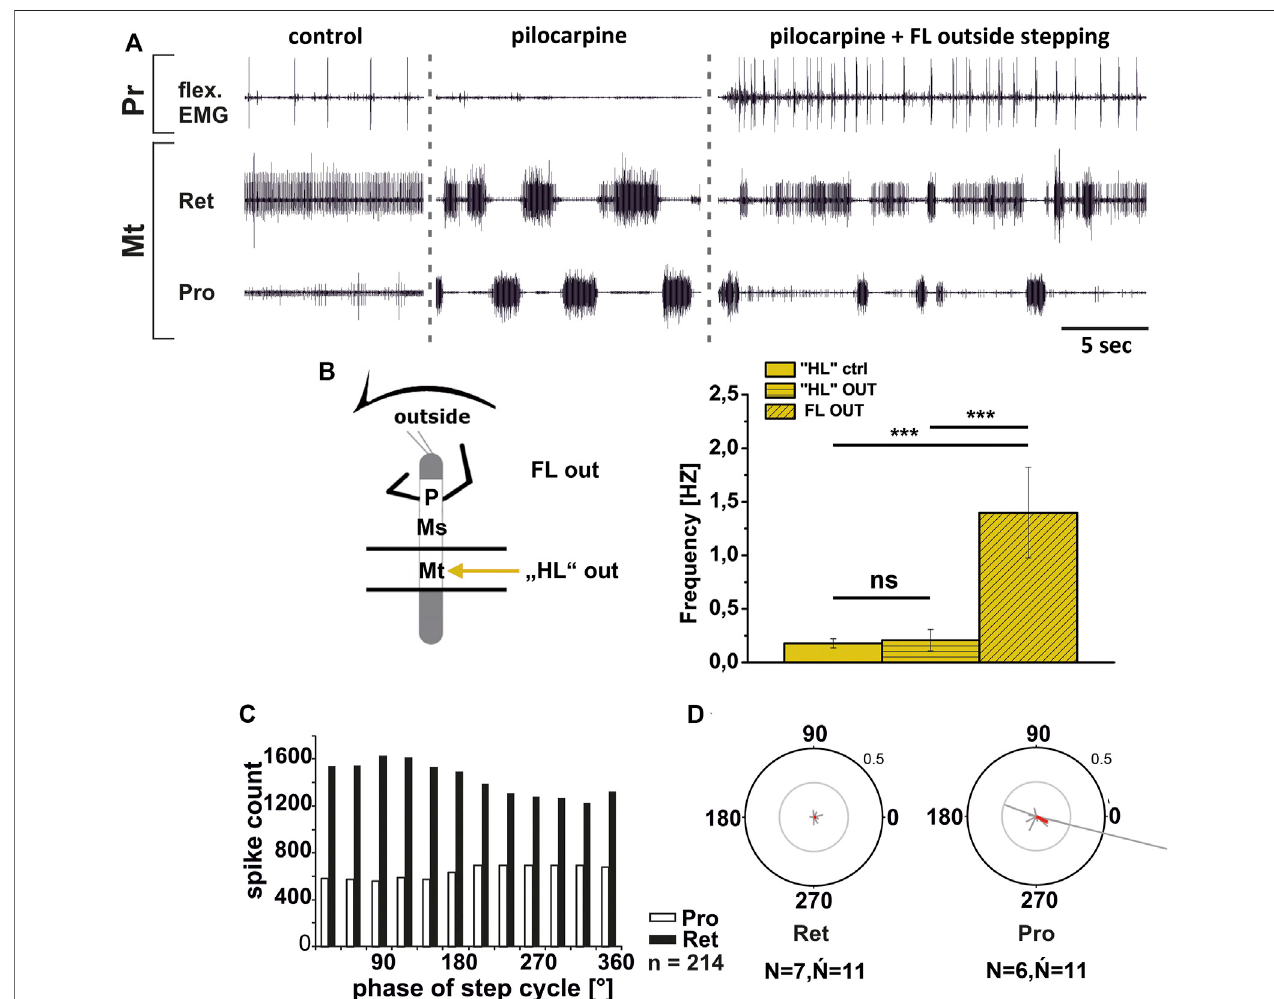
FIGURE7| Motoroutputof protractor (Pro)and retractor (Ret) coxae MNpoolsinthepilocarpineactivateddeafferentedmetathoracicganglionduringfrontleg(FL) outside stepping; (A) . FL Flexor EMG ( “ fl ex ” , top), and extracellular recordings of the ipsilateral metathoracic retractor (second trace) and protractor (third trace) nerve during control outside steps, in pilocarpine w/o FL steps, and during outside stepping under pilocarpine application; (B) . Schematic of experimental split-bath con fi gurationwithcomparison ofnl2pilocarpinecontrolBurstfrequency( “ HL ” ctrl)withdeafferentHL-segmentnl2burstfrequency( “ HL ” OUT)duringoutsidesteps of the front legs (FL OUT) from 14 walking sequences in 10 experiments (signi fi cance level < 0.001); (C) . Phase histogram of retractor and protractor nerve activity under pilocarpine during outside stepping, with respect to the FL step cycle; (D) . Polar plots with the spike event maxima (grey vectors) and their means (red) for the metathoracic retractor (left) and protractor (right) during pilocarpine application with respect to the FL step cycle; N = number of animals; Ń = number of analyzed hemiganglia; n = number of analyzed steps. Pr: Prothoracic/FL segment. The sketch indicates a stick insect with front legs in a fl exed (inside) or stretched (outside) position, and the arrow above indicating the turning direction, the arrow on the side the recorded thoracic segment. The black bars symbolize the vaseline barrier.